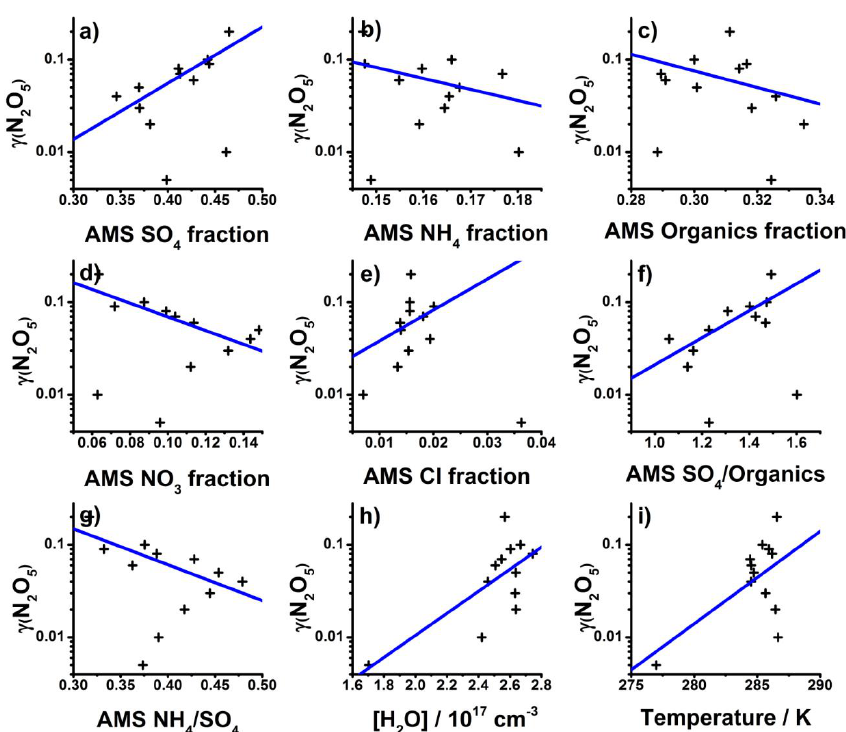
Figure 14: Relationships between the optimised values for γ N2O5 and the corresponding (a) fractional contribution of sulfate aerosol to the total aerosol mass, (b) fractional contribution of ammonium aerosol to the total aerosol mass, (c) fractional contribution of organic aerosol to the total aerosol mass, (d) fractional contribution of nitrate aerosol to the total aerosol mass, (e) fractional contribution of chloride aerosol to the total aerosol mass, (f) ratio of sulfate aerosol mass to organic aerosol mass, (g) ratio of ammonium aerosol mass to sulfate aerosol mass, (h) water vapour concentration, and (i) temperature. The best fit lines are shown in blue, and are described by (a) y = 1.8 × 10 -3 exp(7.8 x ), (b) y = 0.8exp(-18.2 x ), (c) y = 4.2exp(-14.8 x ), (d) y = 6.3 × 10 -2 exp(-3.8 x ), (e) y = 9.9 × 10 -2 exp(-49.5 x ), (f) y = 4.3 × 10 -3 exp(1.7 x ), (g) y = 0.5exp(-6.0 x ), (h) y = 4.4 × 10 -5 exp(2.7× 10 -17 x ), and (i) y = 1.6 × 10 - 30 exp(0.2 x ).